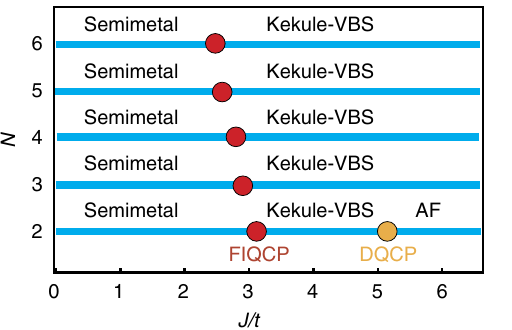
Fig. 3 The quantum phase diagram obtained from QMC simulations. The quantum phase diagram of the models of SU( N ) fermions on the honeycomb lattice, for N = 2, 3, 4, 5 and 6, is obtained by sign-problem-free Majorana quantum Monte Carlo (QMC) simulations. For N = 2, 3, 4, 5 and 6, the system encounters a continuous transition violating the Landau cubic criterion, dubbed as fermion-induced quantum critical point (FIQCP) here, between the Dirac semimetals to the Kekule valance bond solid (Kekule- VBS) phase. For N = 2, the quantum phase transition between the Kekule- VBS and the antiferromagnetic (AF) phases is a decon fi ned quantum critical point